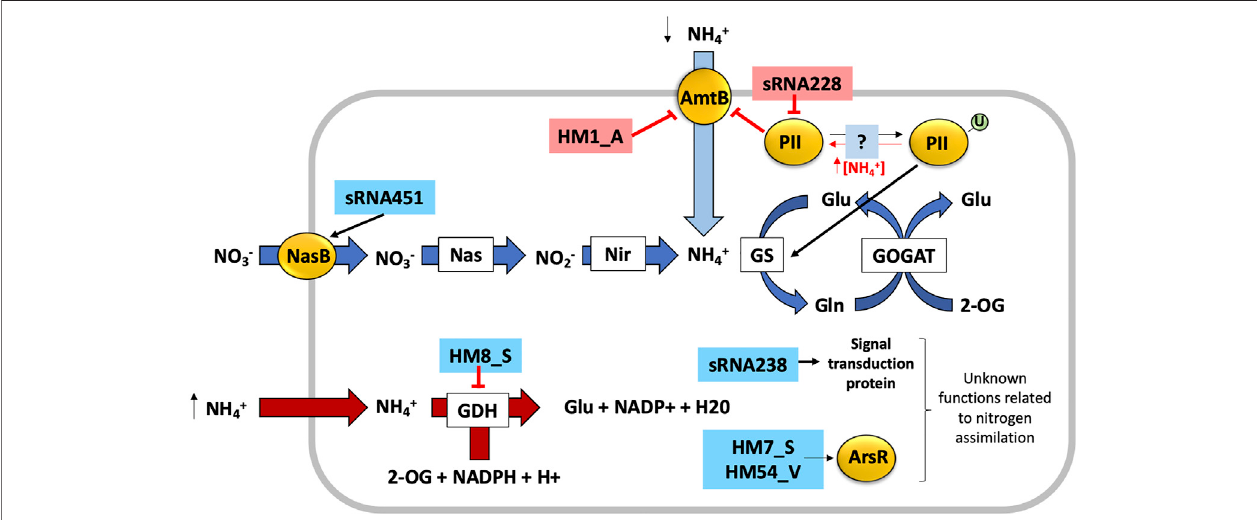
FIGURE4| ProposedregulationofnitrogenassimilationbysRNAsin H.mediterranei. ThesRNAshighlightedinredcorrespondtosRNAsexpressedinpresenceof ammonium,whilesRNAs shaded blue correspond tothoseexpressed inthepresence ofnitrate asasourceofnitrogen. Thered arrows indicate negative regulationand the black arrows indicate positive regulation of their respective target